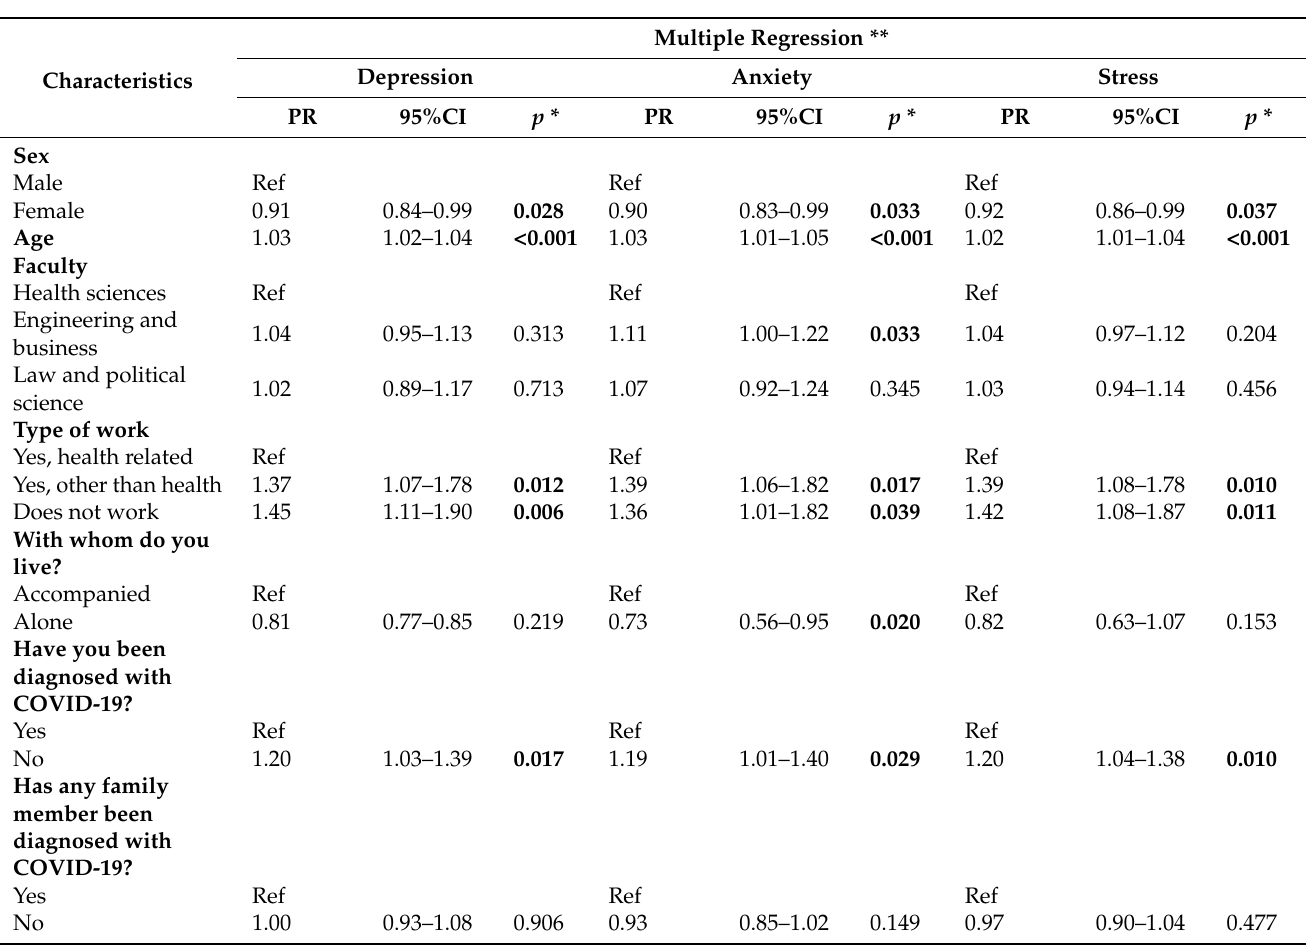
Table 4. Factors associated with depression, anxiety, and stress in students of the Universidad Norbert Wiener. Multiple